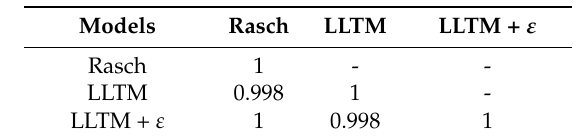
Table 9. Person parameter correlations between models.